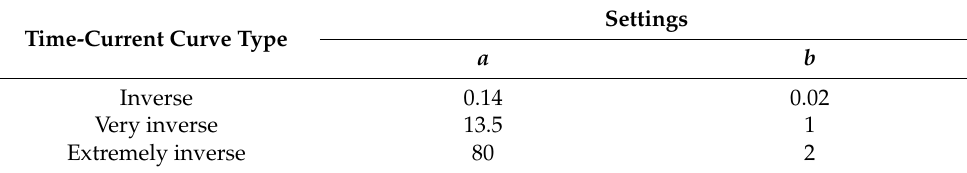
Table 1. Parameters for the different relay characteristics used in the Institute of Electrical and Electronic Engineers (IEEE)-13 bus test feeder system used in the present work (see Equation (1)). These values were selected according to the IEC 60255-51